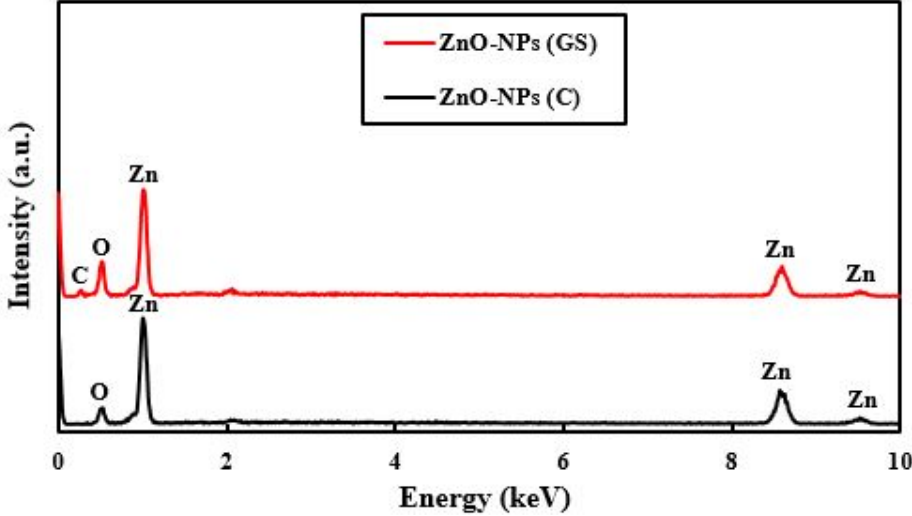
Figure 2. Energy-dispersive X-ray spectroscopy (EDX) spectra of commercial (C) and green synthesized (GS) ZnO-NPs.